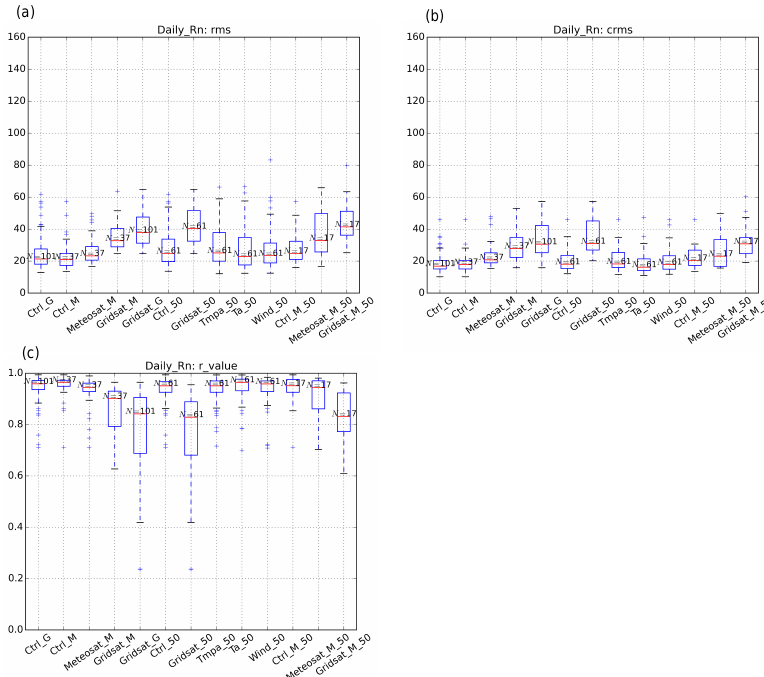
Figure D1. Similar error statistic for R N like Fig. 5 but for daily timescales: (a) RMSD, (b) cRMSD, (c) correlation coefficient.